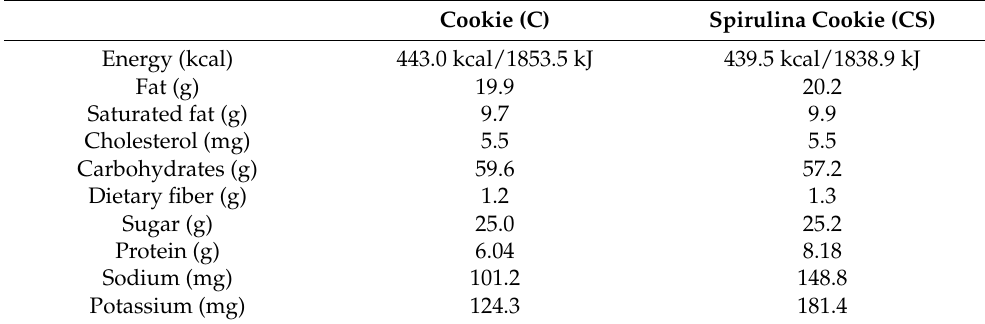
Table 1. Nutrient analysis per 100 g of cookie and spirulina cookie.